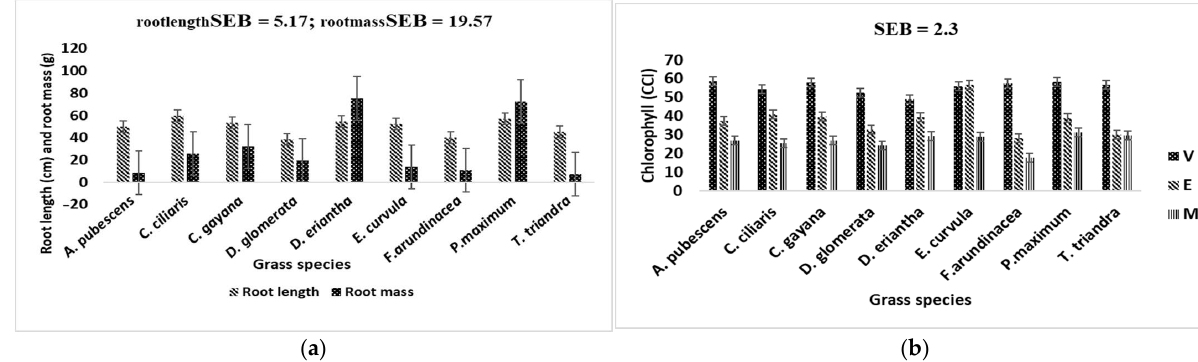
Figure 2. Effect of grass species on root length (cm) and root weight (g) ( a ) and chlorophyll content index (CCI) ( b ), of nine selected grass species at maturity stage. V = vegetative stage; E = elongated stage; M = maturity stage. SEB = standard error